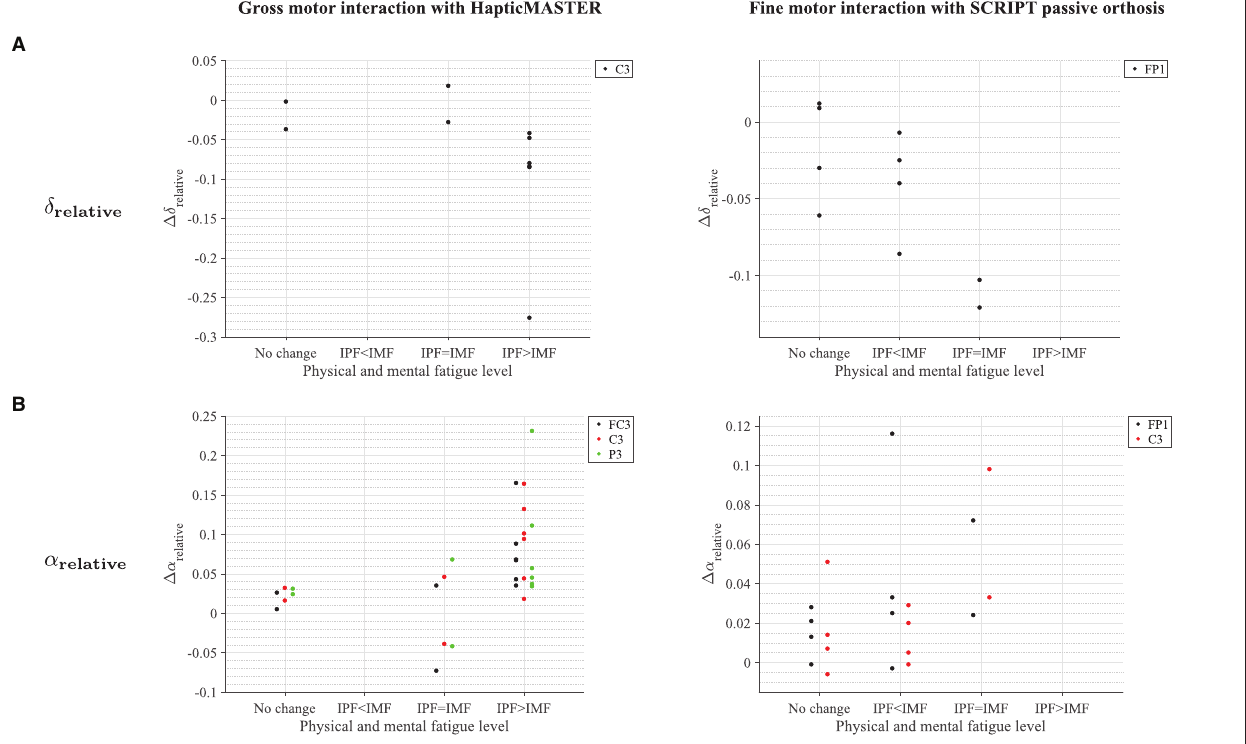
FIGURE 12 | Comparison of the modulations in δ relative and α relative with the variations in fatigue levels following the (A) robot-mediated gross motor interaction with HapticMASTER and (B) robot-mediated fine motor interaction with SCRIPT passive orthosis. The 1 represents the difference in each EEG feature following the robot-mediated interactions (i.e., recovery - baseline). The “IPF” and “IMF” refers to the increase in physical and mental fatigue scores following the robot-mediated interactions, respectively. No change refers to no increase or a decrease in both fatigue